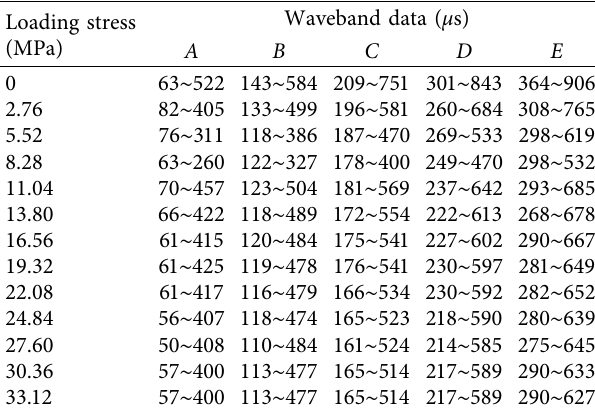
Table 1: Waveband data of wavelet decomposition. Loading